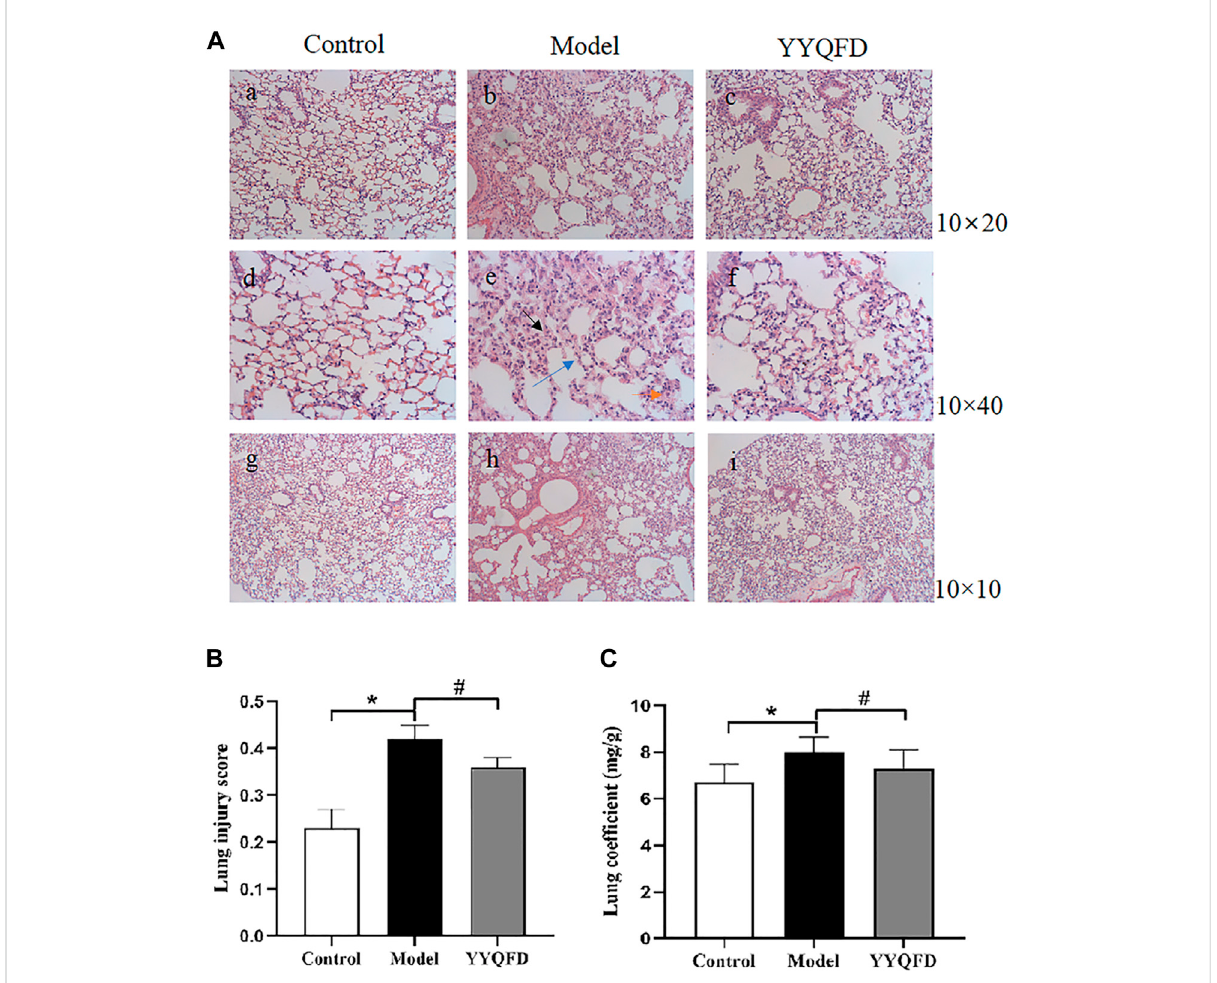
FIGURE 1 Histopathological changesoflungtissues (A) Pulmonarytissue slicesstainedbyH&E ofeach group(Bars,a, b,c×200;d,e, f×400; g,h,i×100), blackarrowsindicatedthickeningofalveolarwalls,bluearrowsindicatedalveolarcollapse,andorangearrowsindicatedin fl ammatorycellin fi ltration (B) Lung injury score of mice (C) Lung coef fi cients of mice. * p < 0.05 vs. control group, # p < 0.05 vs. model